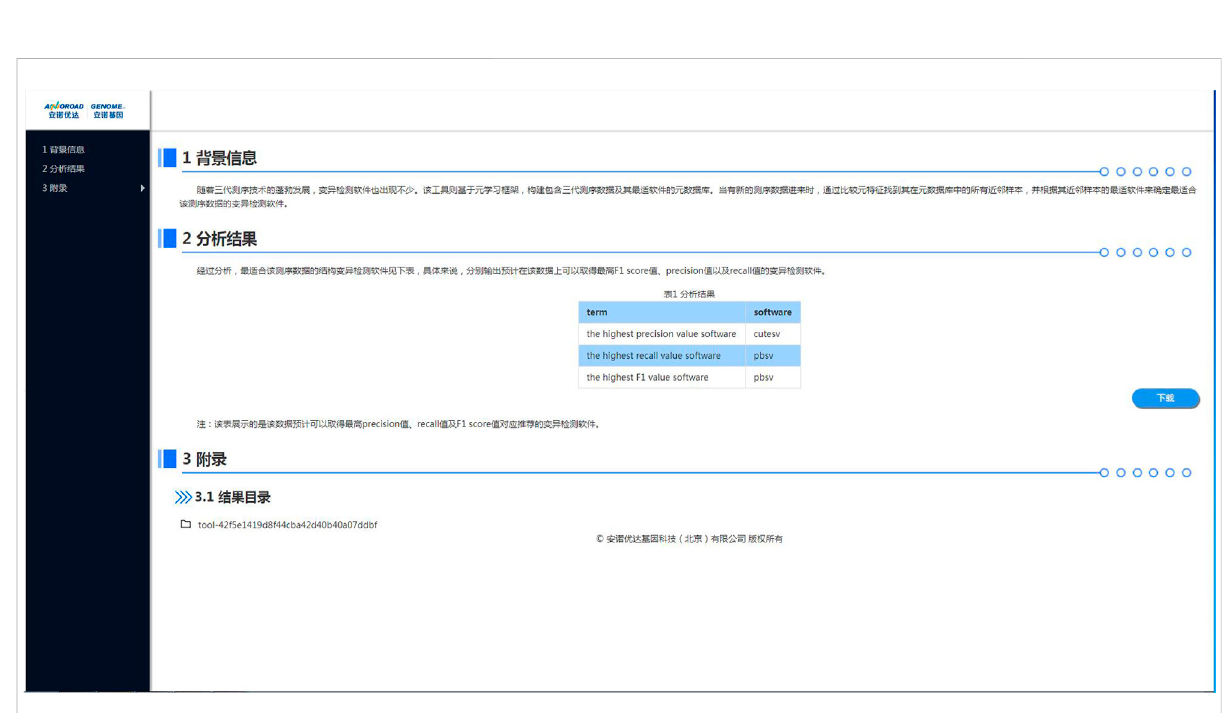
FIGURE 8 The online recommendation tool output